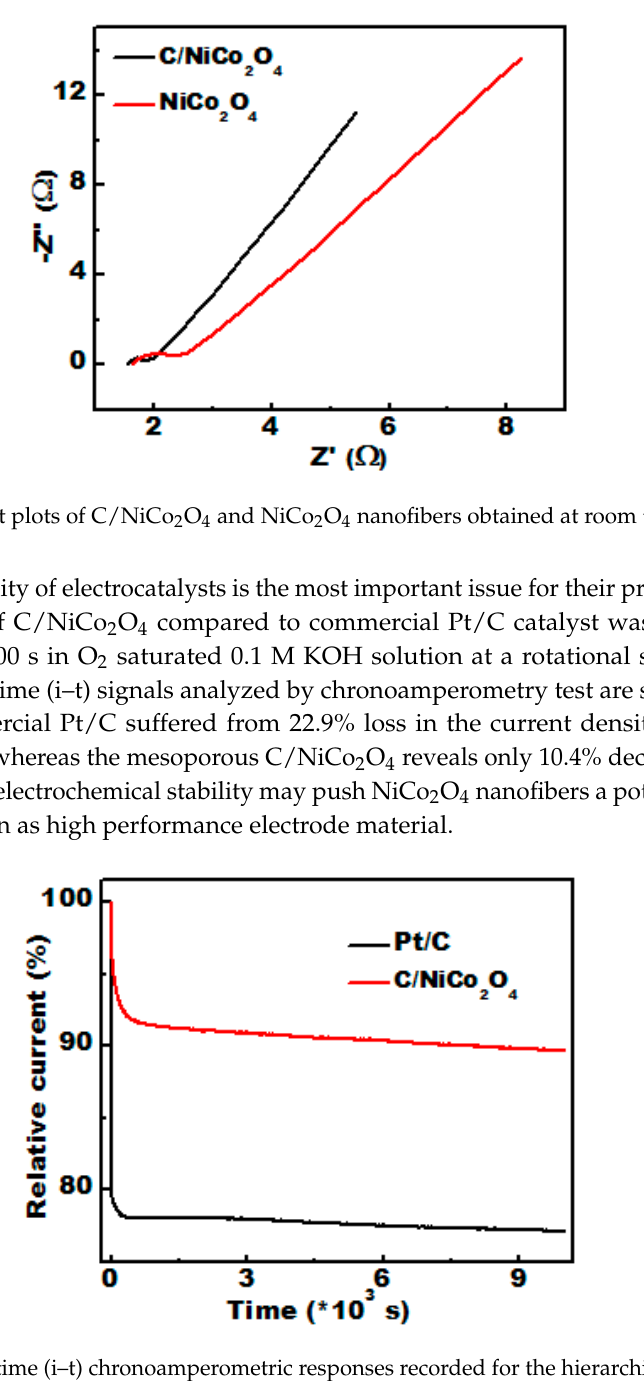
Figure 10. Current–time (i–t) chronoamperometric responses recorded for the hierarchical C/NiCo 2 O